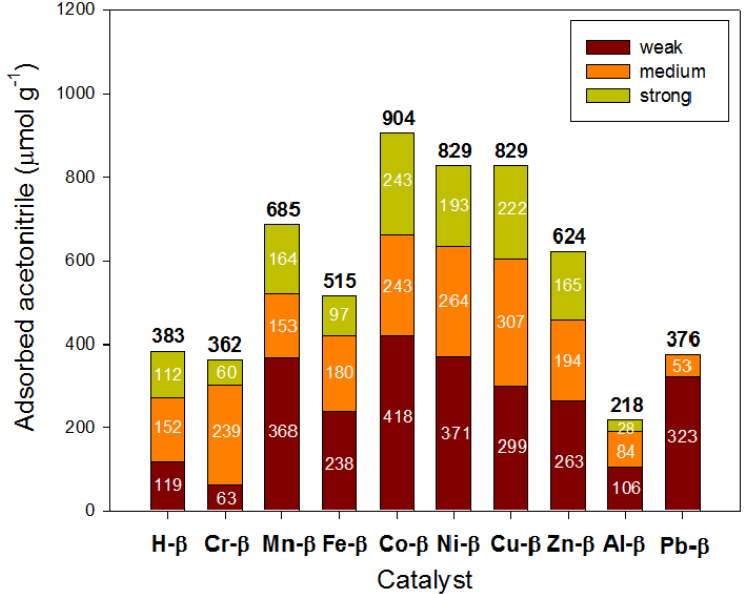
Figure 4. Surface acidity of metal exchanged β zeolites determined by thermal programmed desorption of